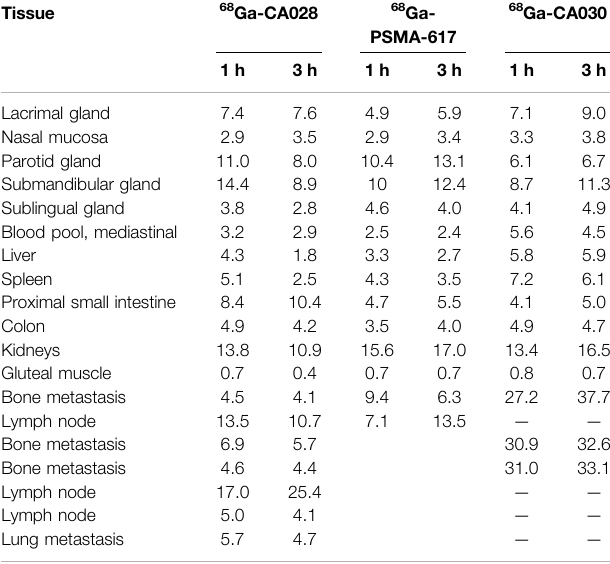
TABLE3| SafetydosimetryofdiagnosticSUVmeanvaluesof 68 Ga-CA028, 68 Ga- PSMA-617 [values from Afshar-Oromieh et al. (2015a) and Afshar-Oromieh et al.(2015b)], and 68 Ga-CA030 andbasedonanadultmale phantominOLINDA. Tissue 68 Ga-CA028 68 Ga- PSMA-617